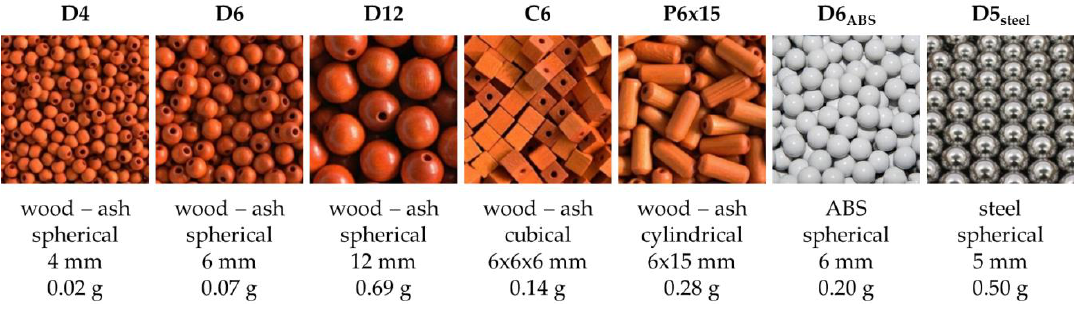
Figure 2. Particulate materials and their basic properties.